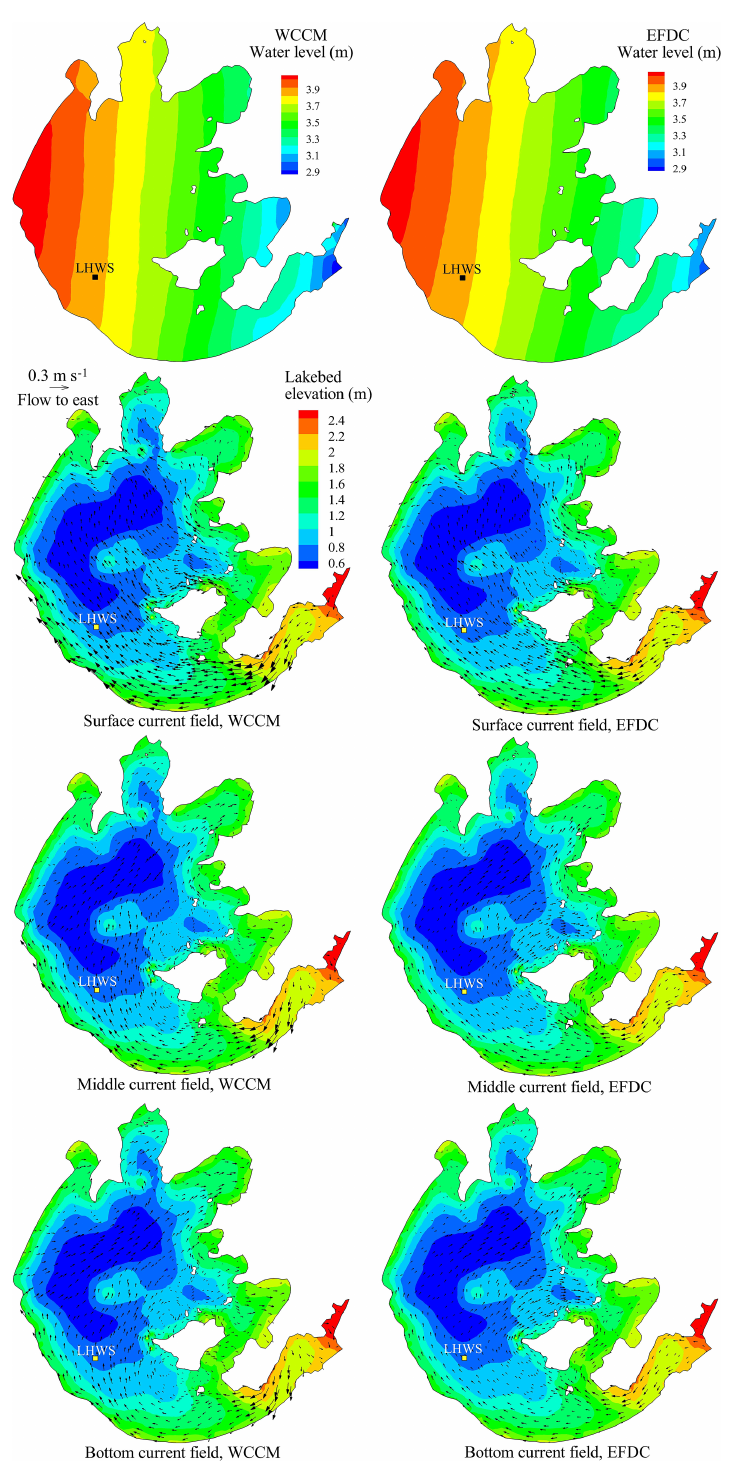
Figure 8. Comparison of the contour of water level and current fields in the surface, middle, and bottom water layers simulated by the WCCM with those simulated by the EFDC at 13:00LT on 10 August